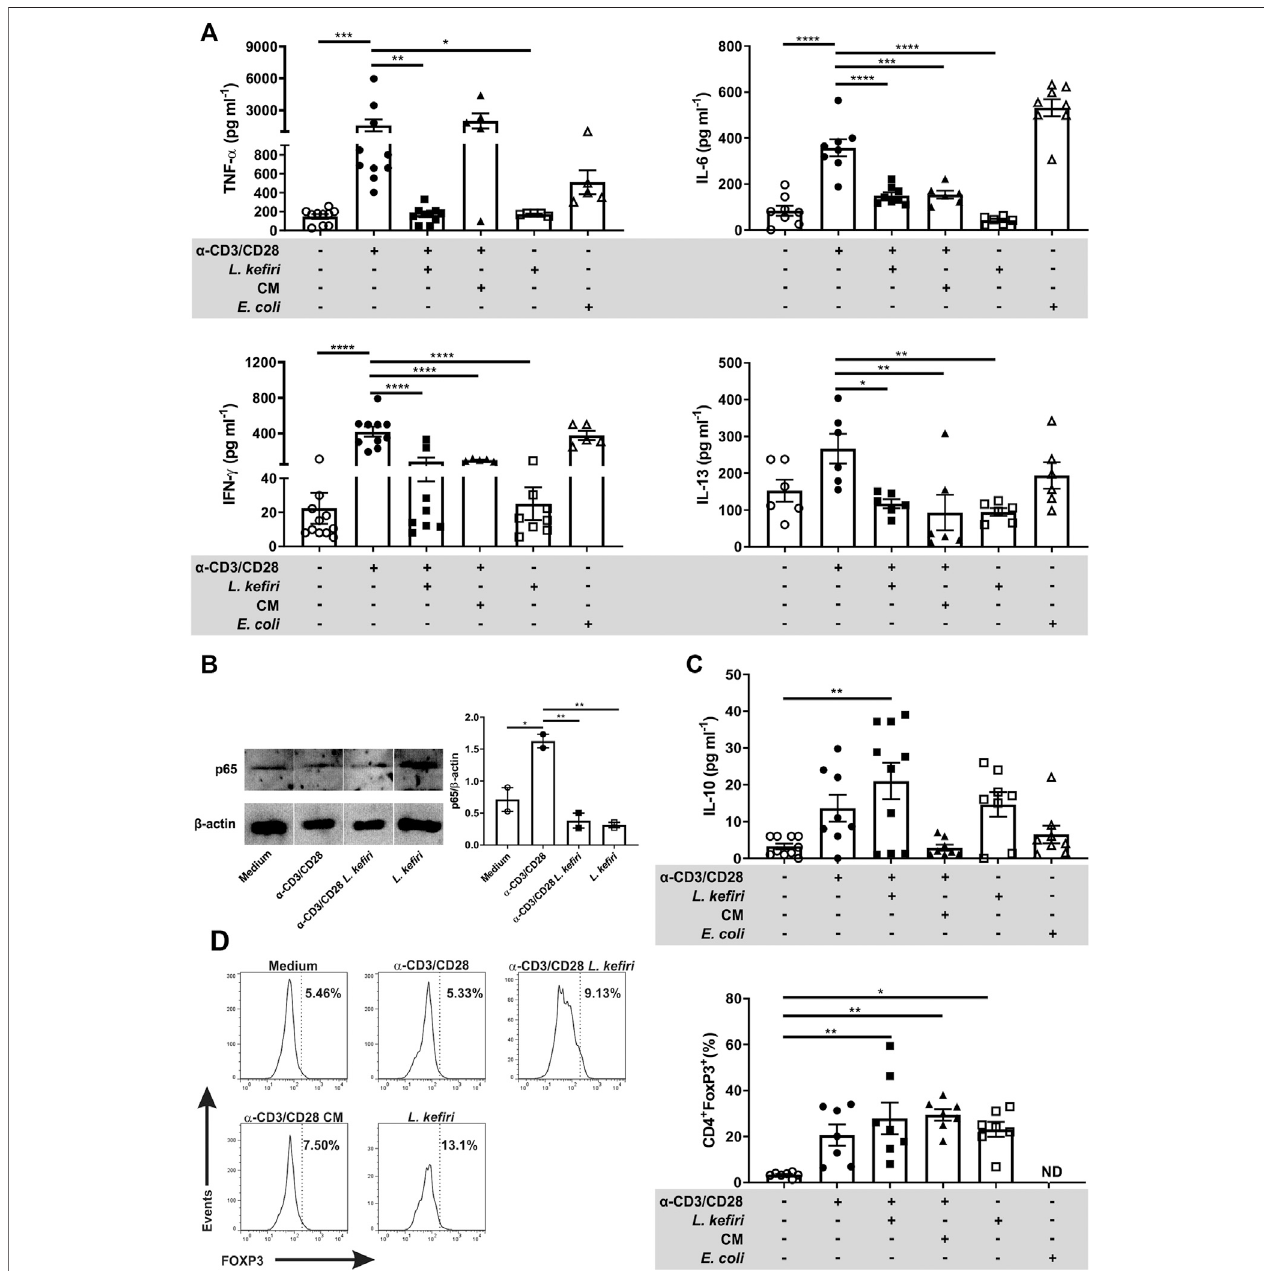
FIGURE 3 | Lactobacillus ke fi ri modulates LPTC cytokine secretion, FOXP3 expression and NF- κ B signaling (A). Effect of L. ke fi ri and CM on cytokine secretion from activated LPTC. Cytokines were assessed by ELISA (B) . Immunoblots of LPTC protein extracts after 30 min of stimulation (representative of two independent assays) and statistical analysis of intensities of bands corresponding to p65 (C) . Quanti fi cation of IL-10 by ELISA in supernatants of the same LPTC assays shown in A (D). Representative histograms of the fl ow cytometry data analysis of LPTC. Frequency of CD4 + FOXP3 + T cells after 4 days incubation with live probiotic or CM. FOXP3 + cells were evaluated in CD4 + cells from the lymphocytes gate. Anti-CD3 and anti-CD28 antibodies were used for T cell activation. * p < 0.05, ** p < 0.01, *** p < 0.001, **** p < 0.0001.